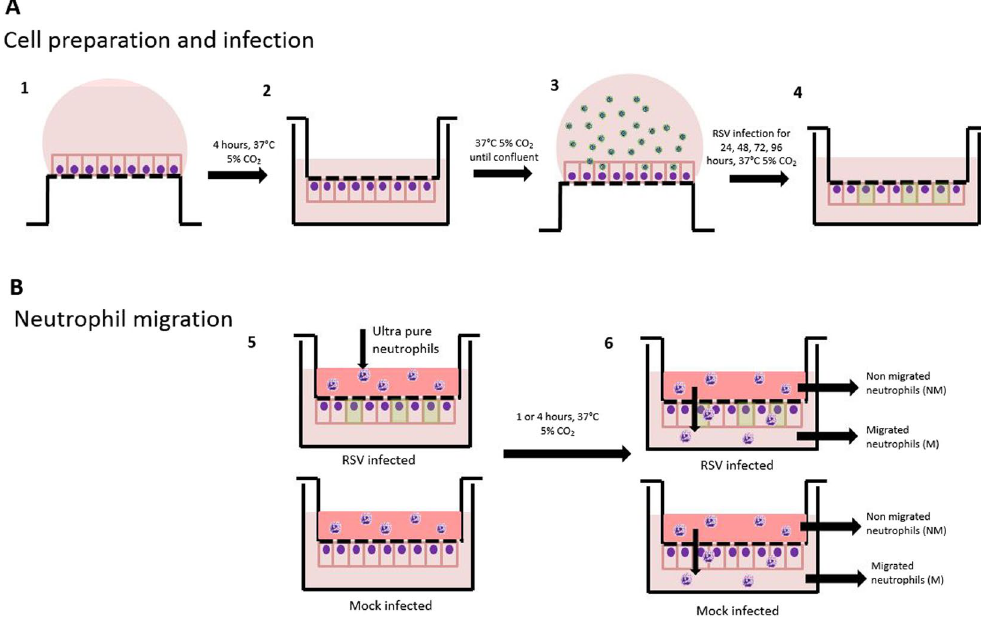
Figure 1. Schematic diagram of neutrophil migration model. Diagram of cell seeding, A549 infection (A) and neutrophil migration (B) . (1) A549 cells were seeded onto the underside of a transwell and allowed to attach for 4 hours. (2) Transwells were subsequently inverted and maintained in media to allow a confluent epithelial monolayer to develop for 72 hours. (3) Transwell were inverted and infected with GFP RSV or mock infected for 2 hours. (4) Transwell s were inverted and maintained in media and infection allowed to progress for 24, 48, 72 or 96 hours. (5) Ultrapure neutrophils were added to the basolateral side of the transwell, and were allowed to migrate for 1 or 4 hours. Underneath the transwell was HBSS + or RSV infection media. (6) Post migration basolateral and apical neutrophils were collected and downstream analysis